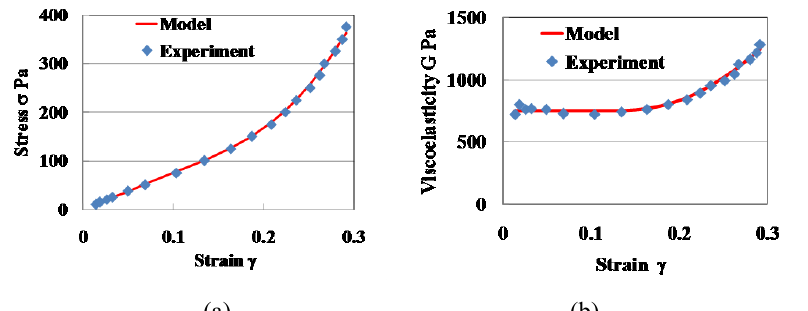
Fig. 4 Relationships of (a) stress-strain and (b) stress-viscoelasticity. Stress is computed by multiplying viscoelasticity by strain (as represented by the